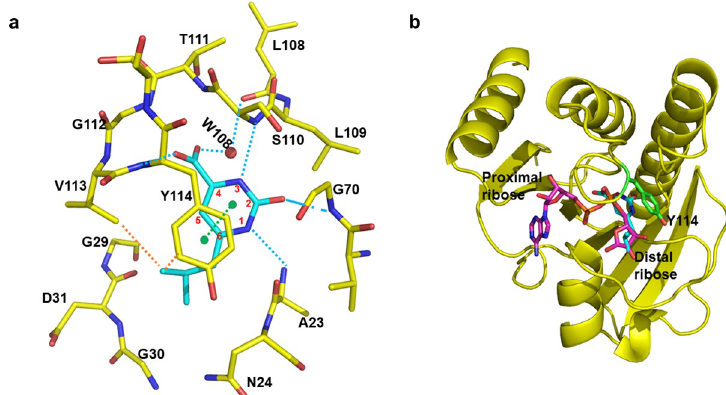
Fig 3. The co-crystal structure of CHIKV nsP3MD with SRI-40582. a) The interaction network between nsP3MD and SRI-40582. SRI-40582 is colored in cyan sticks. Key residues of nsP3 that interact with SRI-40582 are highlighted in yellow sticks. Hydrogen bonds, π - π stacking, and hydrophobic contacts are indicated by cyan, green, and orange dashed lines, respectively. Pyrimidine numberings are shown in red around the ring structure. b) Comparison of SRI- 40582 and ADP-ribose in the nsP3MD structure. The nsP3MD structure is shown in yellow cartoon. A SRI-40582 molecule is colored in cyan sticks and ADP-ribose in magenta sticks. The Y114 of nsP3MD is shown in green sticks.